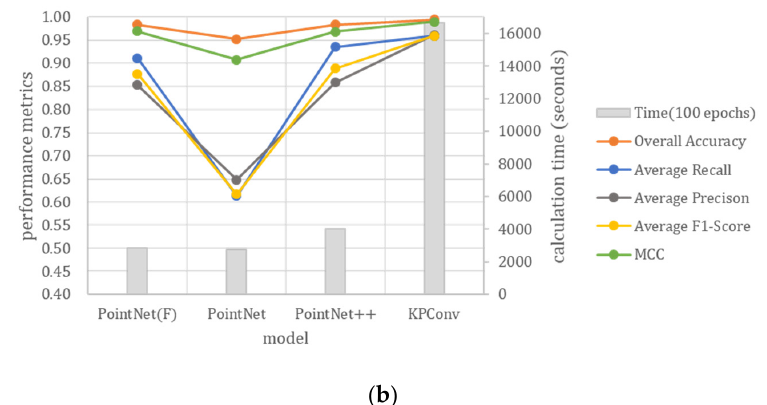
Figure 19. Comparison of classification results and computational efficiency of the deep learning models: ( a ) ALS point cloud; ( b ) MLS point cloud.